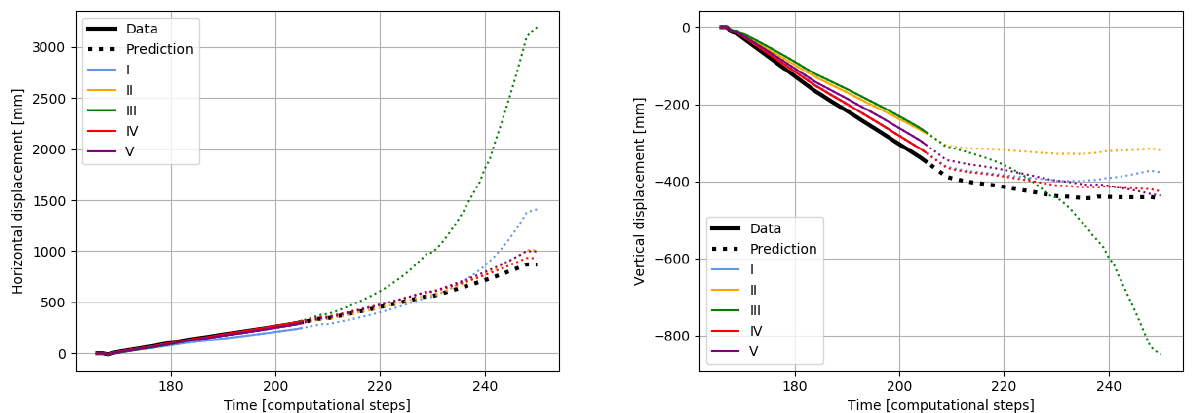
Figure 23: Prediction of horizontal (left) and vertical (right) displacement in benchmark U3.